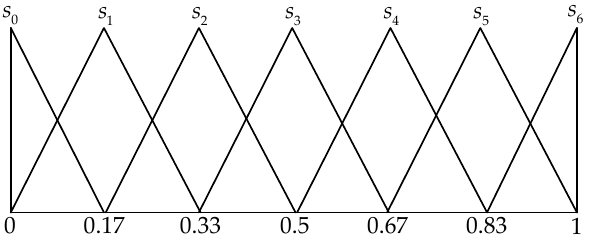
Figure 2. Linguistic terms and corresponding triangular fuzzy membership functions.